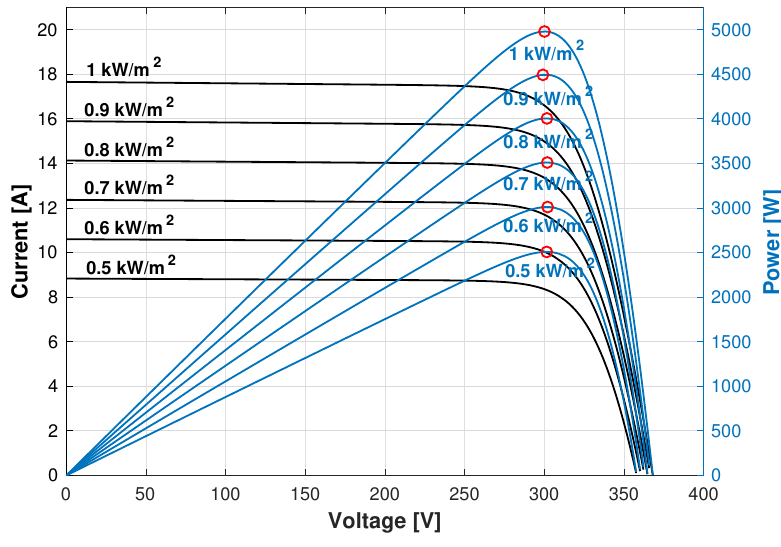
Figure 14. Current (black) and Power (blue) against Voltage curves for high power PV array